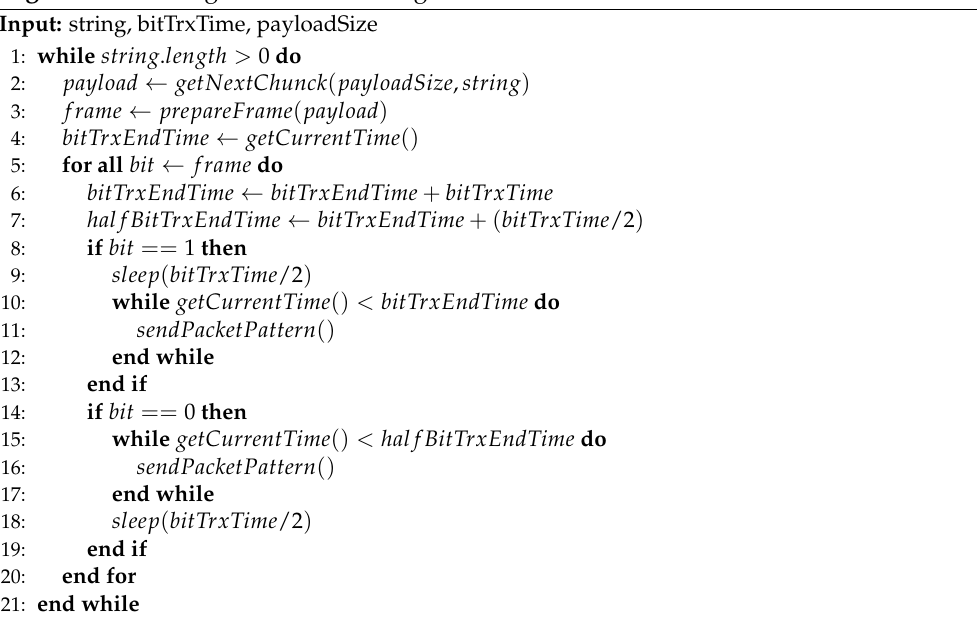
Algorithm 2 EM signal modulation